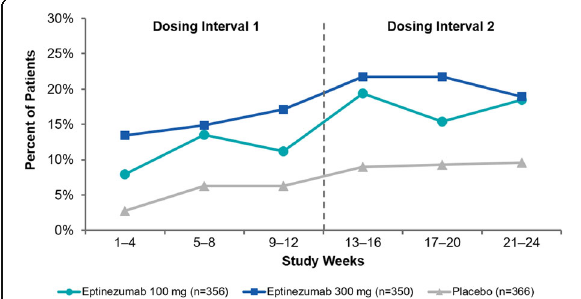
Fig. 5 Rates of 100% migraine response by 4-week interval (efficacy population). † Nominal P < 0.001 vs placebo (analyses of